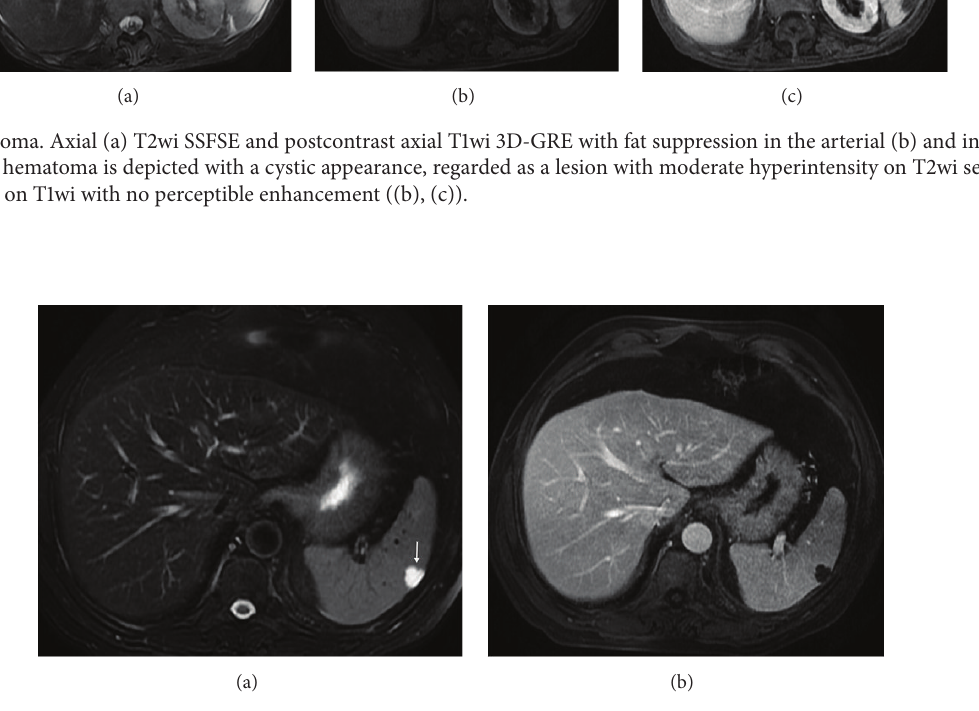
Figure 11: Splenic cyst. Axial T2wi FSE with fat suppression (a) and postcontrast axial 3D-GRE T1wi with fat suppression at the interstitial (b) phase. Note the thin-walled and well-defined nodule, homogeneously hyperintense on T2wi (a), with no enhancement on post contrast image, characteristic of